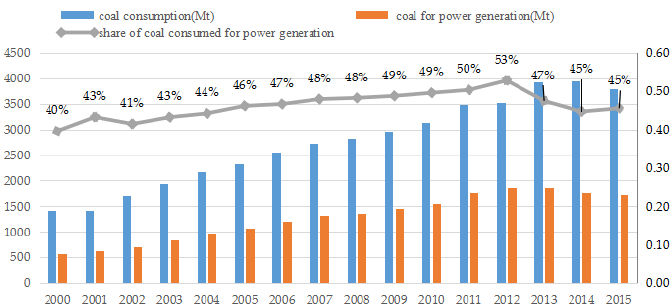
Figure 3. Average thermal efficiency of power plants in China (2008–2015).